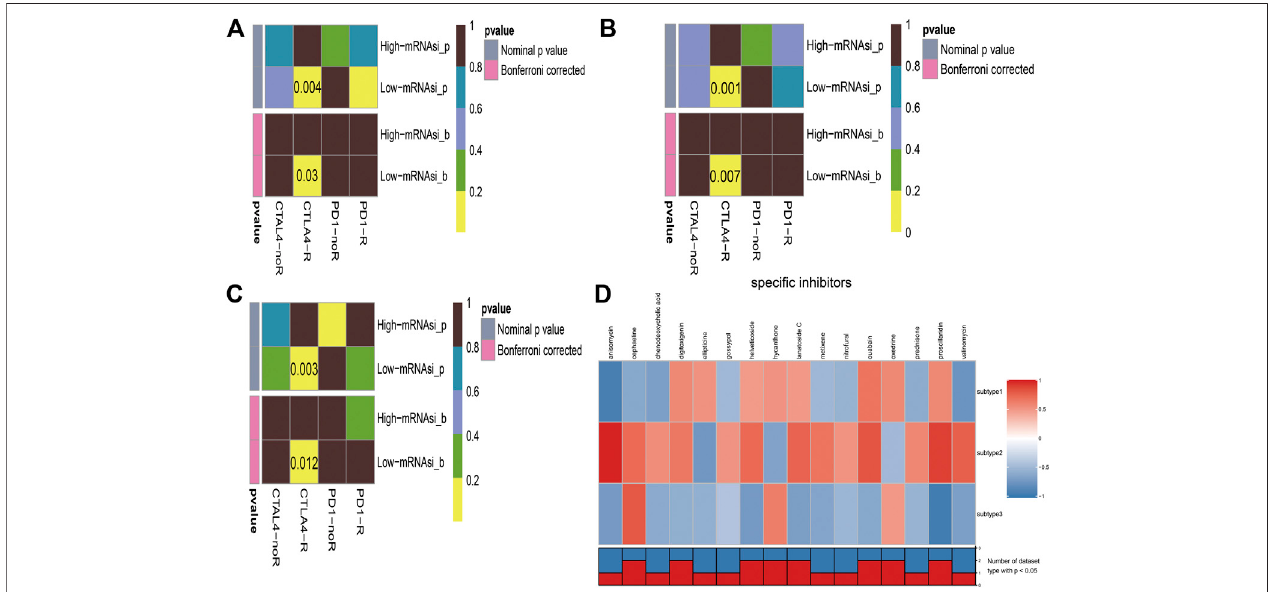
FIGURE 6 | Immunotherapeutic response and potential compounds identi fi cation. (A) : differential immunotherapeutic response targeting CTLA-4 and PD-1 betweenthehigh-andlow-riskpatientsinsubtype1; (B) :differentialimmunotherapeuticresponsetargetingCTLA-4andPD-1betweenthehigh-andlow-riskpatientsin subtype 2; (C) : differential immunotherapeutic response targeting CTLA-4 and PD-1 between the high- and low-risk patients in subtype 3; (D) : heatmap of potential compounds and enrichment score (positive in red, negative in blue) obtained from the Connectivity Map database for each melanoma subtype. The bottom panel showed that the number of subtypes signi fi cantly enriched in